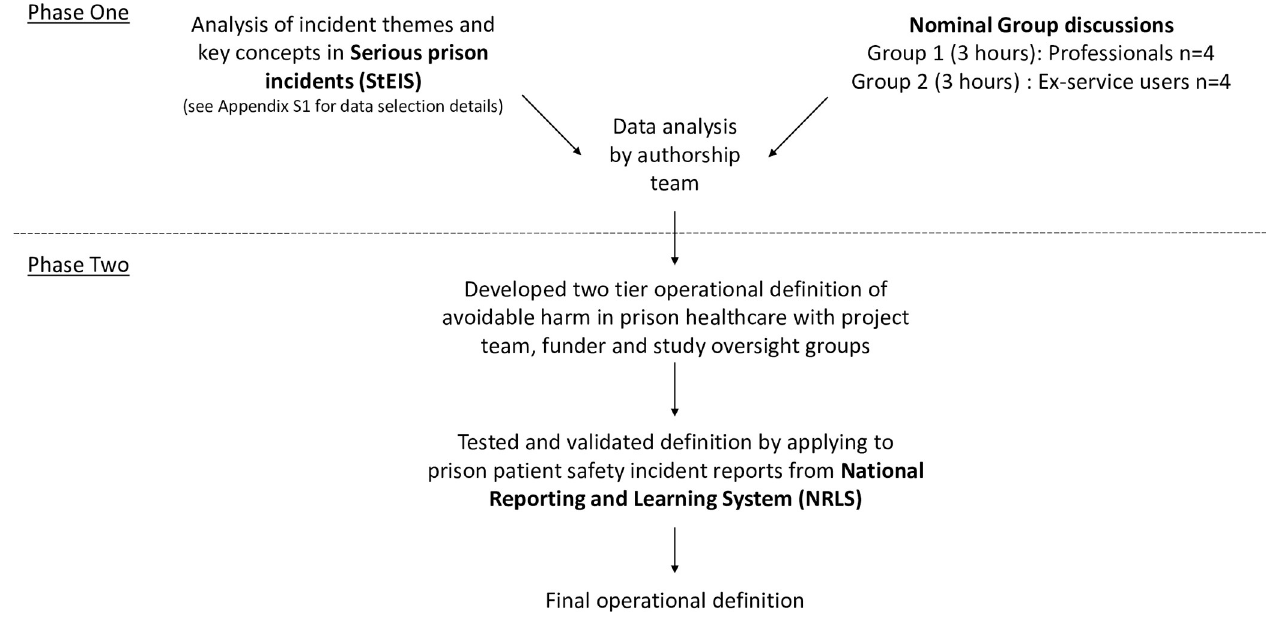
Fig 1. Summary of study